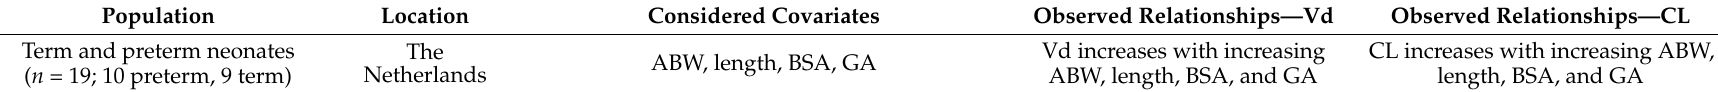
Table 1. Patient characteristics and the main findings of the studies evaluating the covariates of phenobarbital